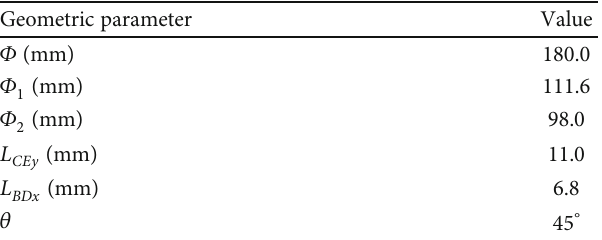
Table 1: Related geometric parameters. Geometric